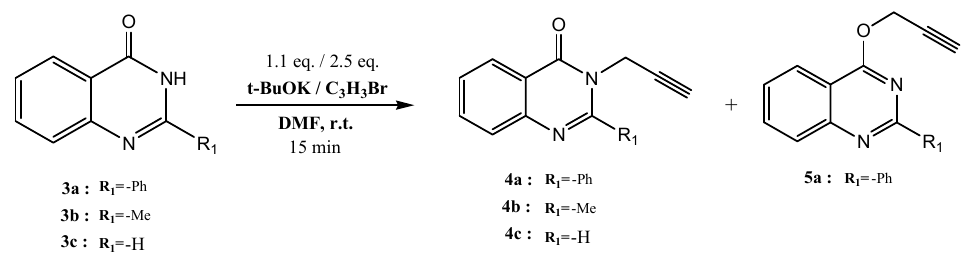
Scheme 2. Synthesis of alkylated quinazolines 4a – c and 5a